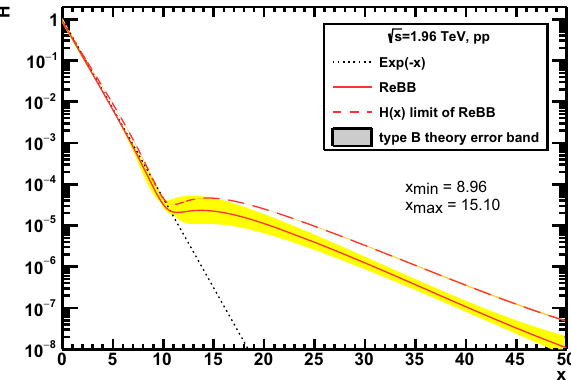
Fig. 28 A theoretical determination of the domain of validity of the √ H ( x ) scaling at s = 1 . 96 TeV within the framework of the ReBB model. As indicated on this plot, the differential cross-sections of elas- tic pp collisions can be evaluated from the full model including the 1 σ theoretical uncertainties of these calculations. The corresponding yellow band can be compared with a similar calculation when the H ( x ) scaling as a constraint is also implemented within the same model. This calculationdoesnotincludethepossiblecompensationofthedeviations by an overall vertical rescaling factor, so it gives a conservative esti- mate for the domain of validity of the H ( x ) scaling as x max ( s ) = 15 . 1 √ s = 1 . 96 at